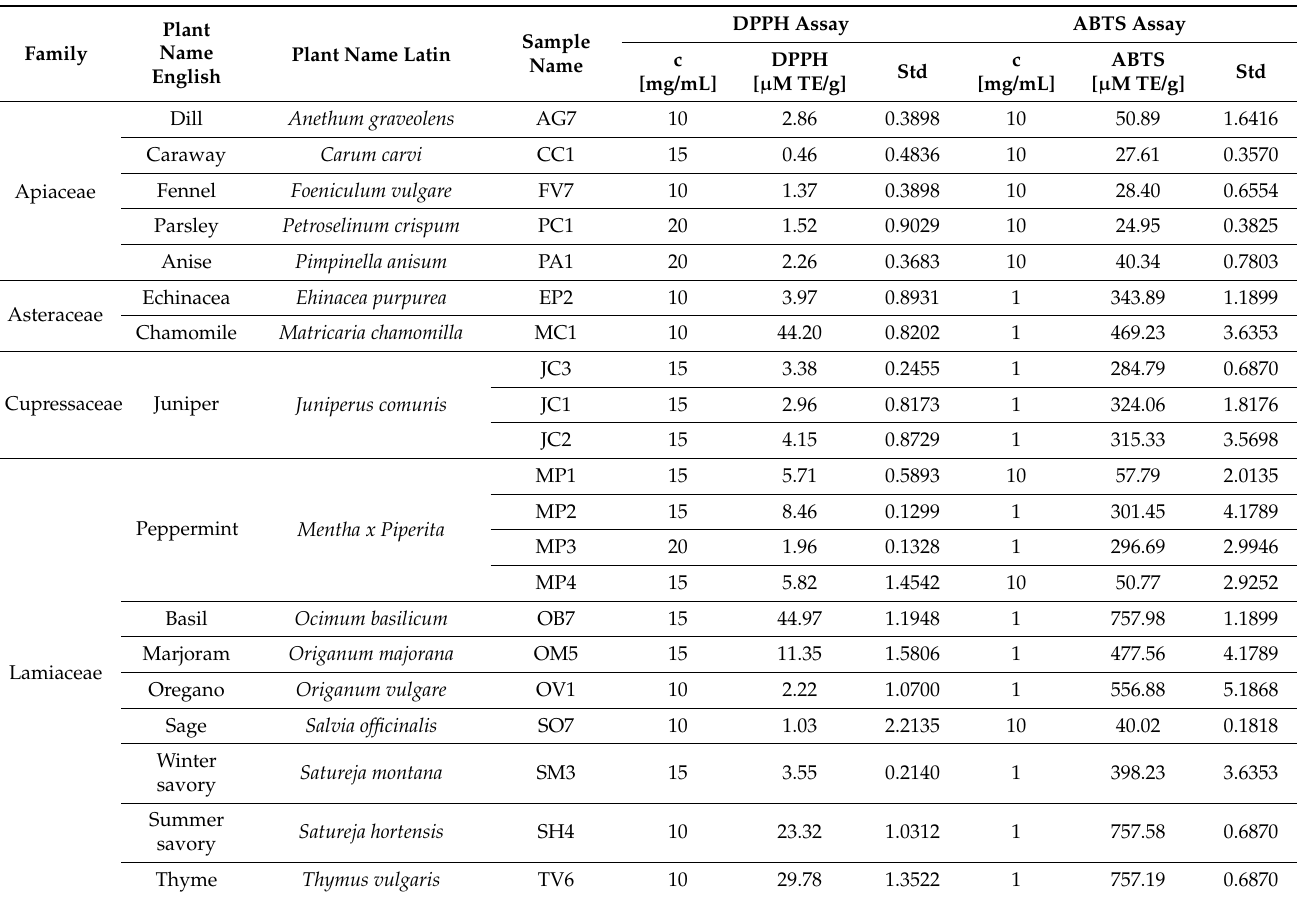
Table 6. DPPH and ABTS + radical scavenging activity of EOs obtained from Apiaceae, Asteraceae, Cupressaceae and Lamiaceae